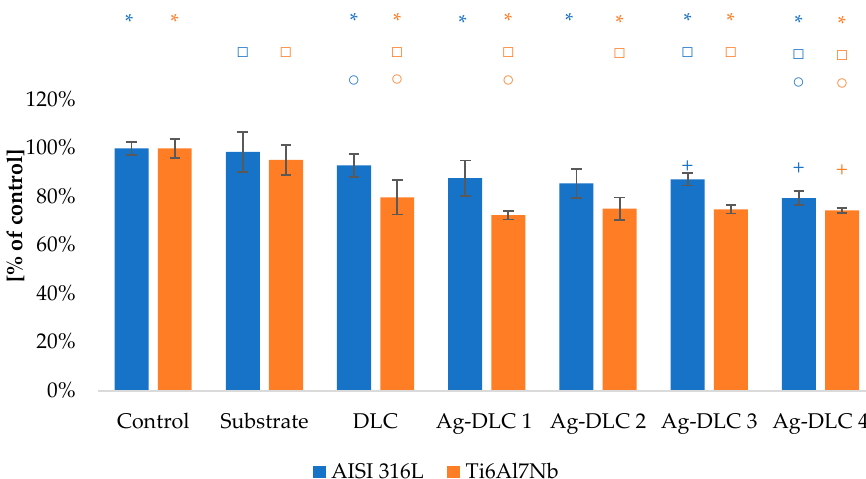
Figure 9. Assessment of proliferation of Saos-2 cells in contact with Ag-DLC coatings. Results of XTT examination.